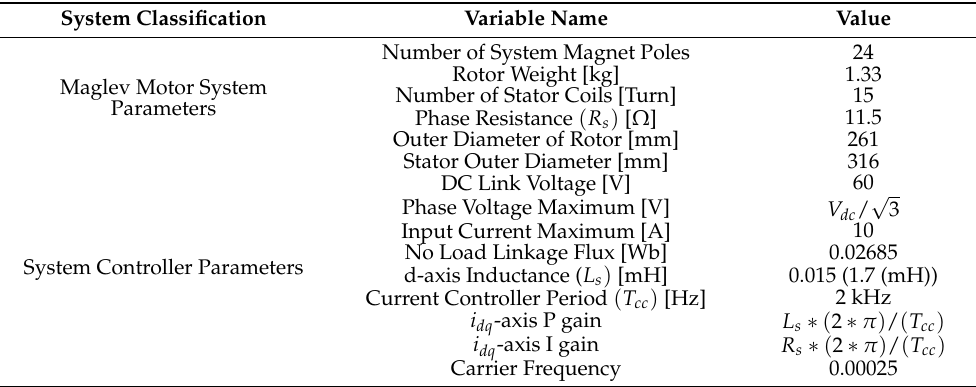
Table 2. Sensing limit range specification of sensor. Sensor Classification